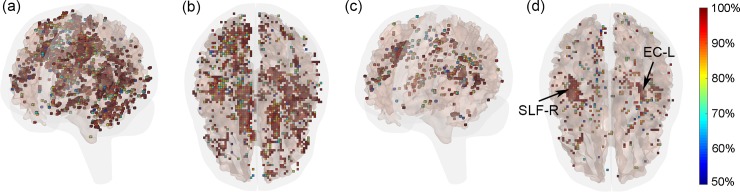
Probability maps for WM voxels selected.(a and b): using the F-score or (c and d) RF-based approach based on 58 independent feature selections. In each trial, the two approaches selected 4% and 1%, respectively, of the WM voxels as features. To improve visualization, only voxels with a probability greater than 50% (i.e., selected by at least 29 times) are shown. For the RF-based approach, SLF-R and EC-L were two dominant regions often selected for classification. See Matlab figure (S1 Fig) in the supplementary for interactive visualization.